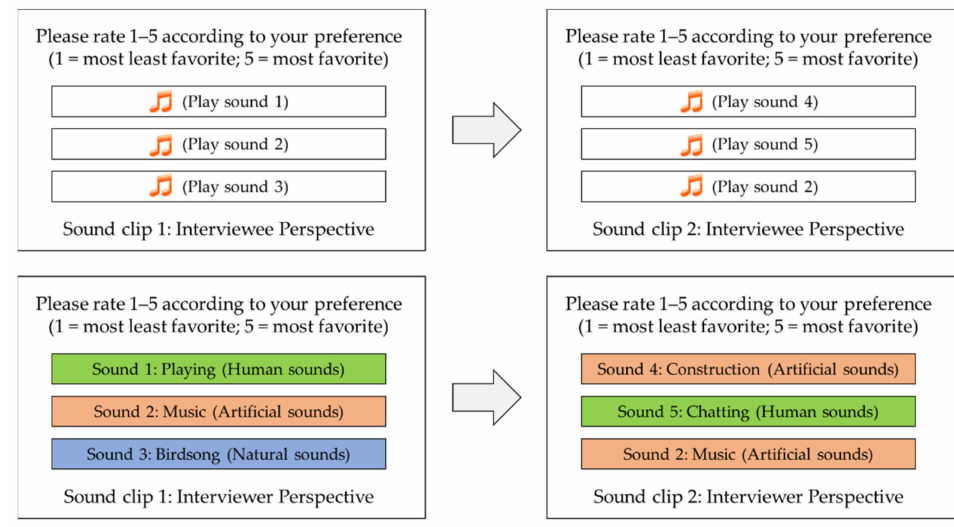
Figure 5. The example of the audio clips and questions used in the survey of this study. The figure was created by the